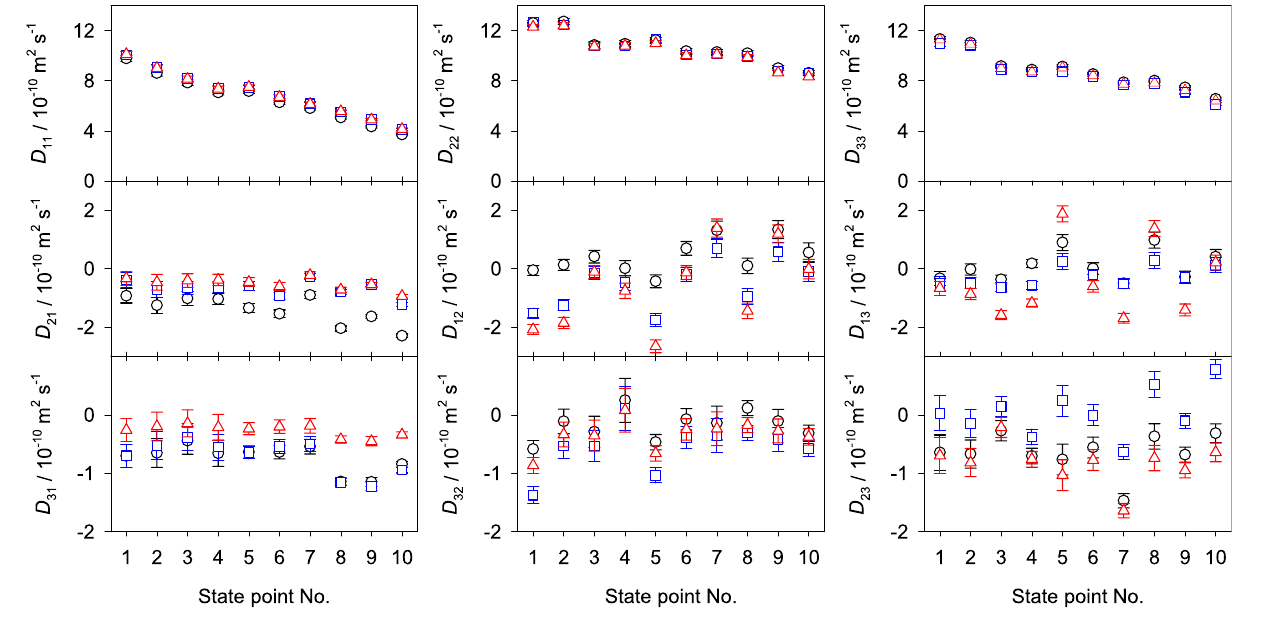
Figure 8. Elements of the Fick diffusion coefficient matrix in the molar (black circles), volume (blue squares) and mass reference frame (red triangles) of the quaternary mixture water (1) + methanol (2) + ethanol (3) + 2-propanol (4) for the regarded ten state points at 298.15 K and 0.1 MPa. The molar composition of the regarded state points is given in the supplementary Table S4